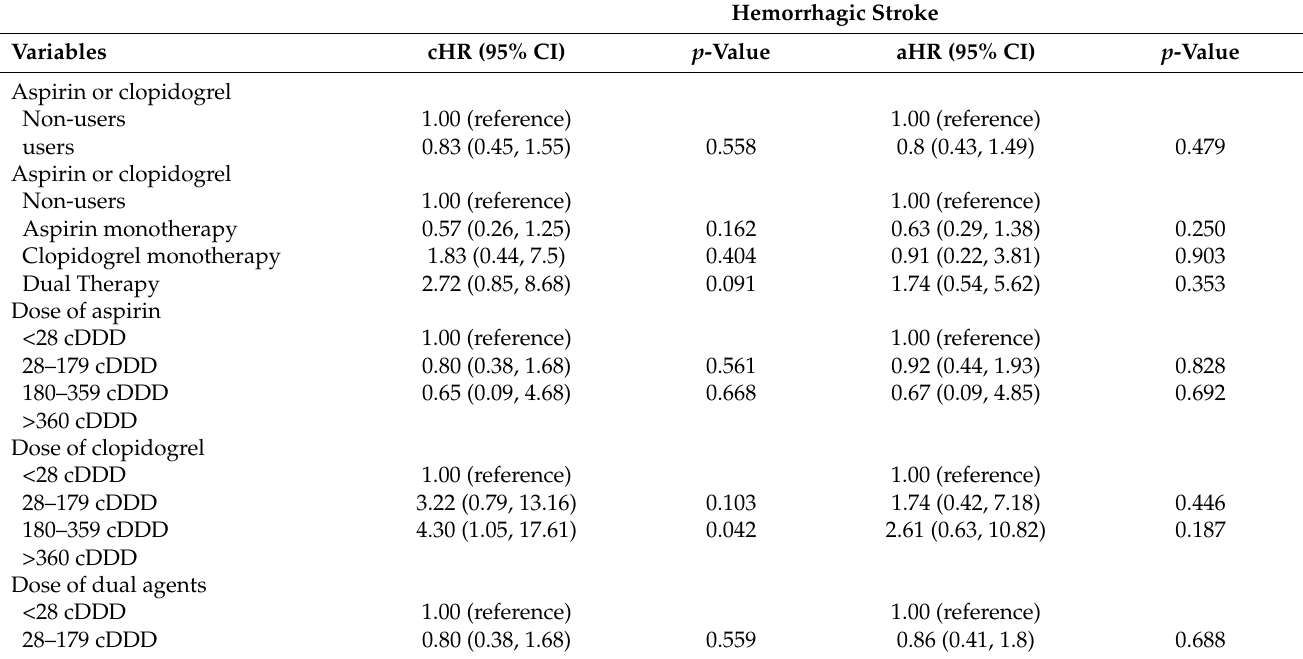
Table 5. The hazard ratio of hemorrhagic stroke among patients taking antiplatelet